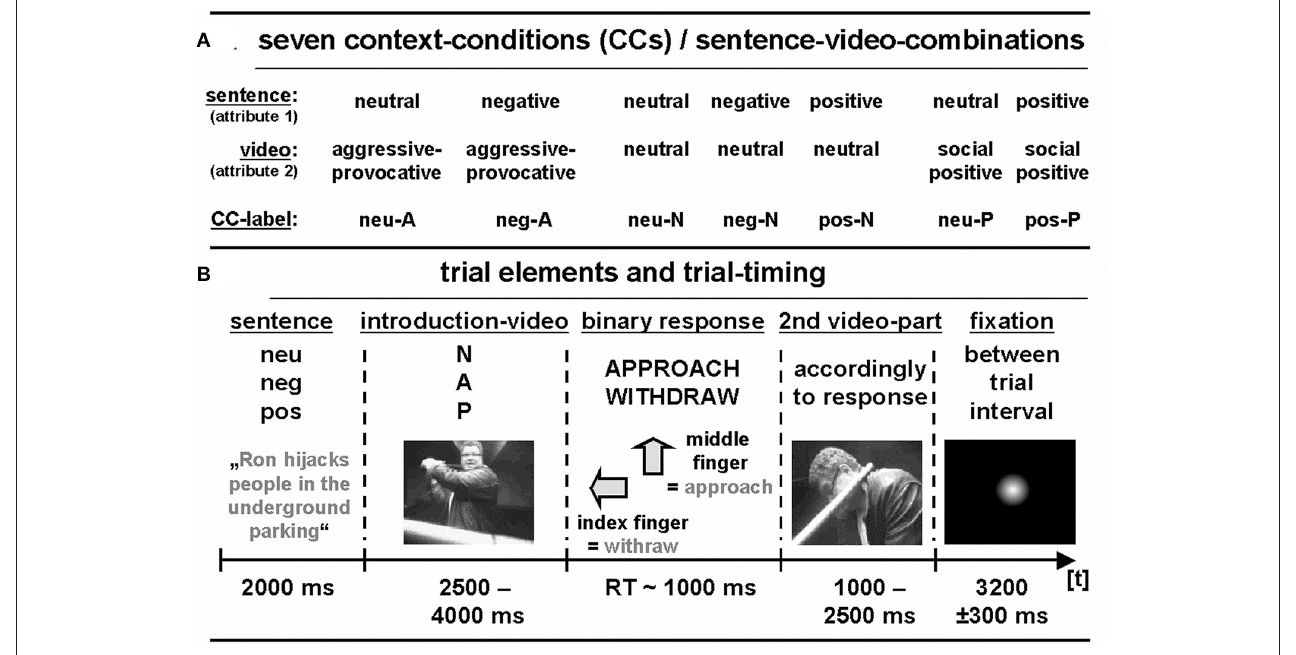
FIGURE 1 | (A) Emotional context conditions (CCs). (B) Trial elements and trial